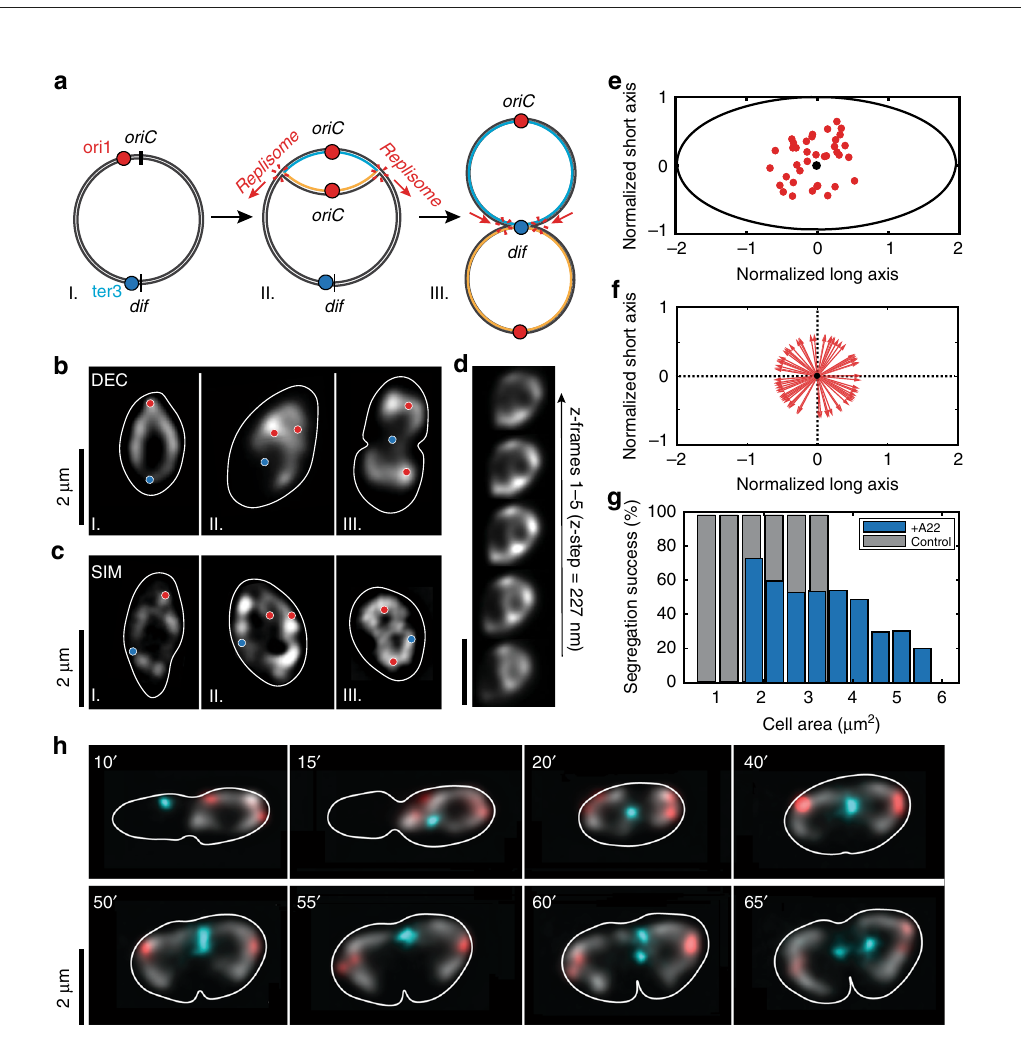
Fig. 3 Direct observation of replication bubble formation in widened cells. a Schematics depicting the process of: I: replisome assembly II: replication fork splitting III: formation of the replication bubble and consecutively IV: sister chromosome separation and visualization formation of the replication bubble (dashed box). b Time lapse images of cell replication, depicting the same four steps as in the schematics shown in panel a. top: DnaN-mCherry signal and bottom: HU-mYpet signal shown in false color, the cell contour is shown as the continuous white line. c Intensity of the mCherry signal along the dotted lines on cells shown in the panel b top. The replisome foci quickly separate and then gradually move away from each other along the circular chromosome. d Intensity of the mYpet signal along the cyan dotted lines on cells shown in the panel b bottom. The intensity along the cross-section of the chromosome gradually widens, until the replication bubble forms and two sister chromosome regions are visible (indicated with black arrows). e Time lapse images of cell replication at longer timescales (HU-mYpet signal shown in false color). Cells do form a division septum at the geometric middle of the cell and eventually divide (80 ′ ). Note that the replicated chromosomes in daughter cells recover the toroidal shape of the chromosome, similarly to the mother cell. f Time-lapse images of replisomes moving along a circular chromosome and then coming back together. Top: overlay of HU-mYpet and DnaN-mCherry signal; bottom: DnaN-mcherry signal ( N = 53). The cell contour is shown as the continuous white line.